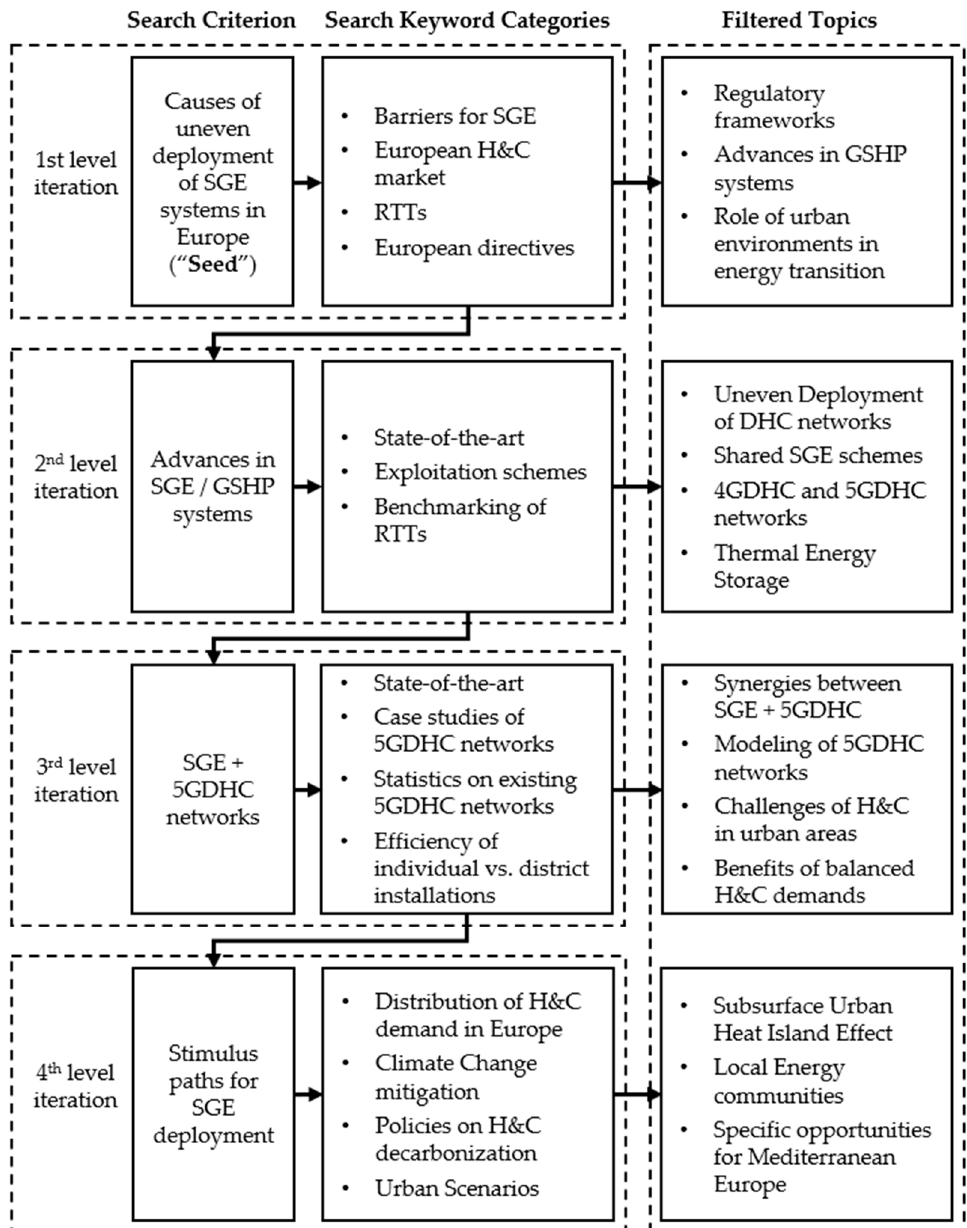
Figure 1. Flowchart showing the iterative process of the literature search. Each search iteration step is carried out through multiple keywords (grouped as “search keywords categories”) and generates a set of bibliographic documents (grouped in topics of interest or “filtered topics”) and the criterion for the next iteration level.